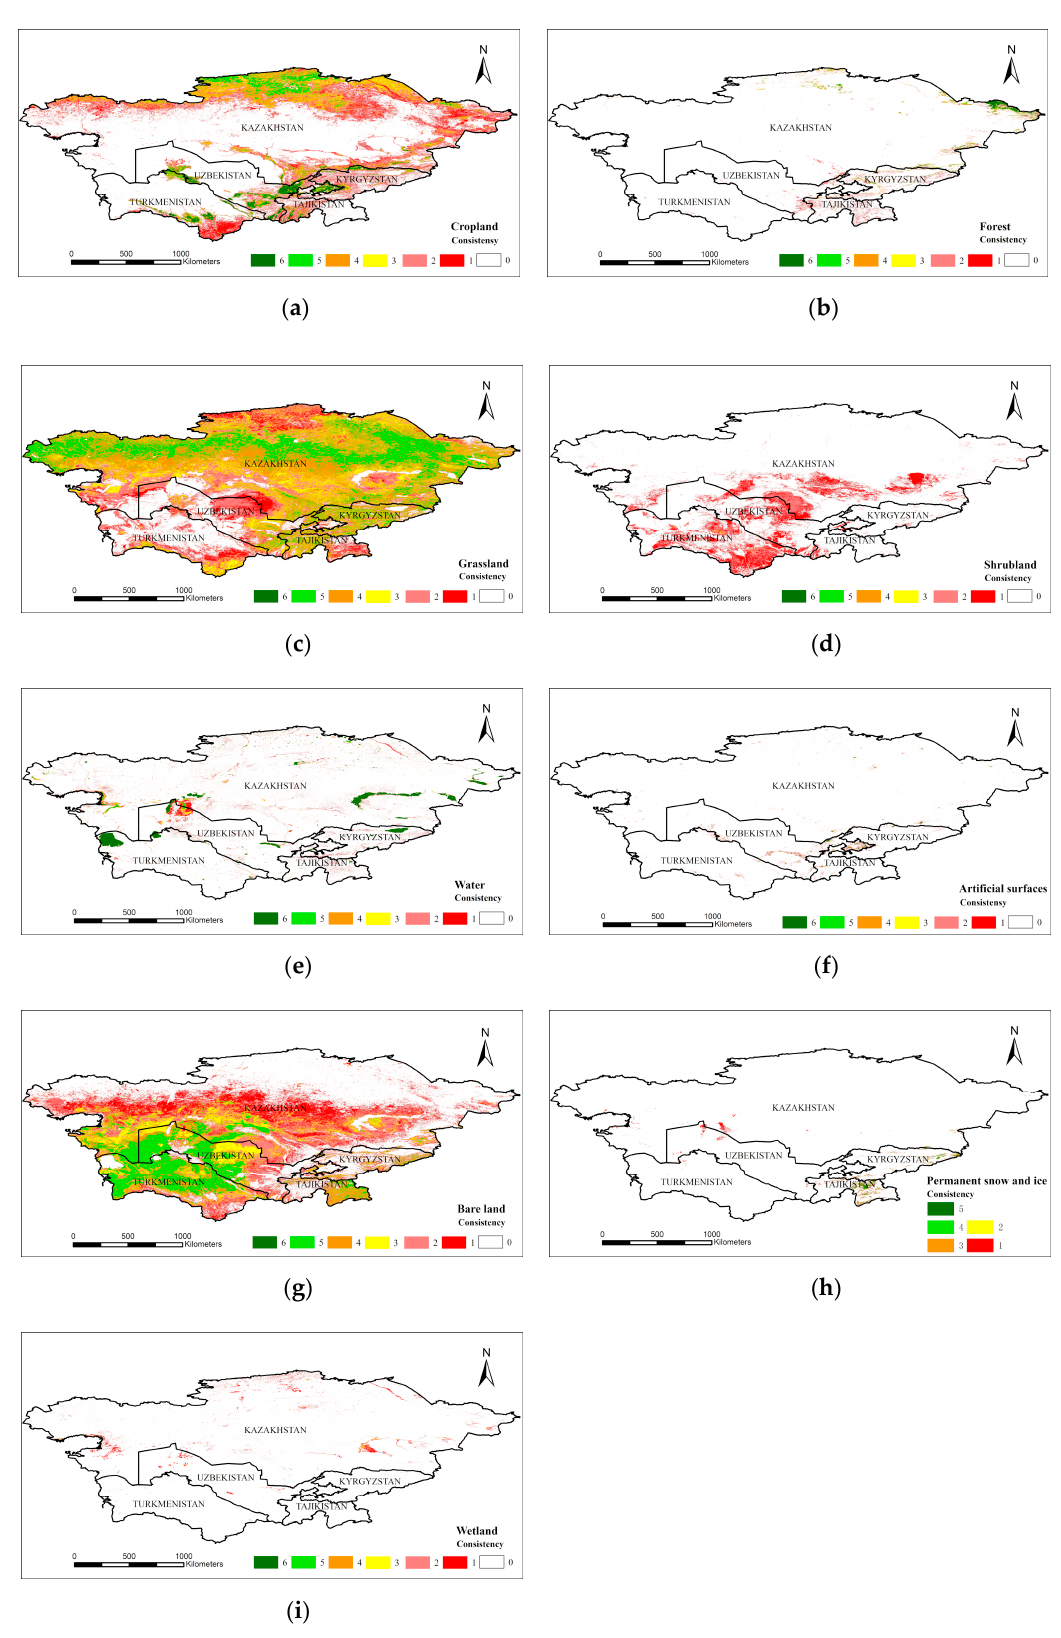
Figure 3. Consistent spatial distribution of multiple landcover products: ( a ) cropland; ( b ) forest; ( c ) grassland; ( d ) shrubland; ( e ) water; ( f ) artificial surfaces; ( g ) bare land; ( h ) permanent snow and ice; ( i ) wetland.